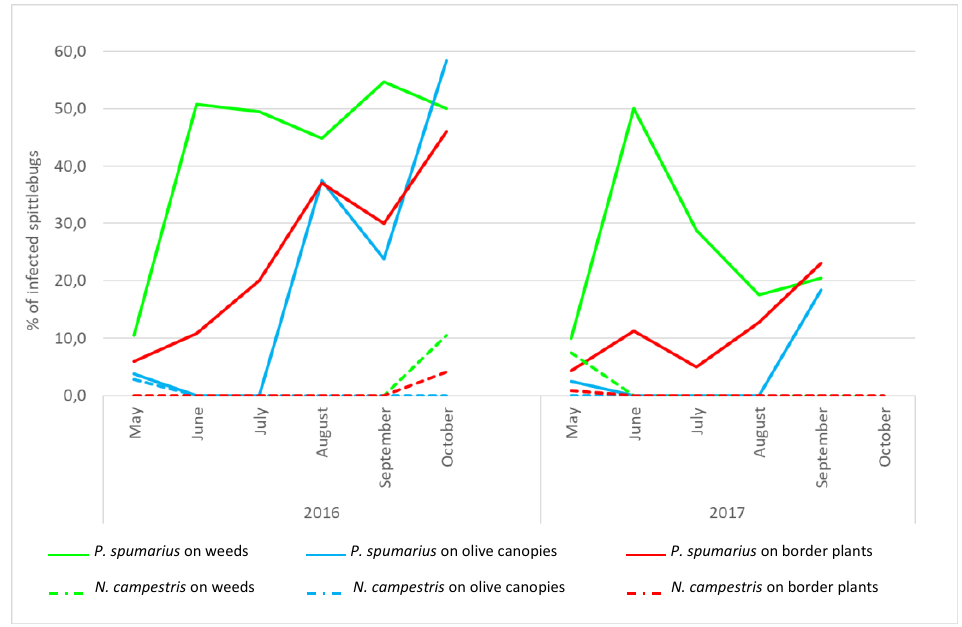
Figure 3. Occurrence of Xylella -positive individuals of Philaenus spumarius and Neophilaenus campestris on infected olive canopies, ground vegetation and border plants, over the two years of surveys .